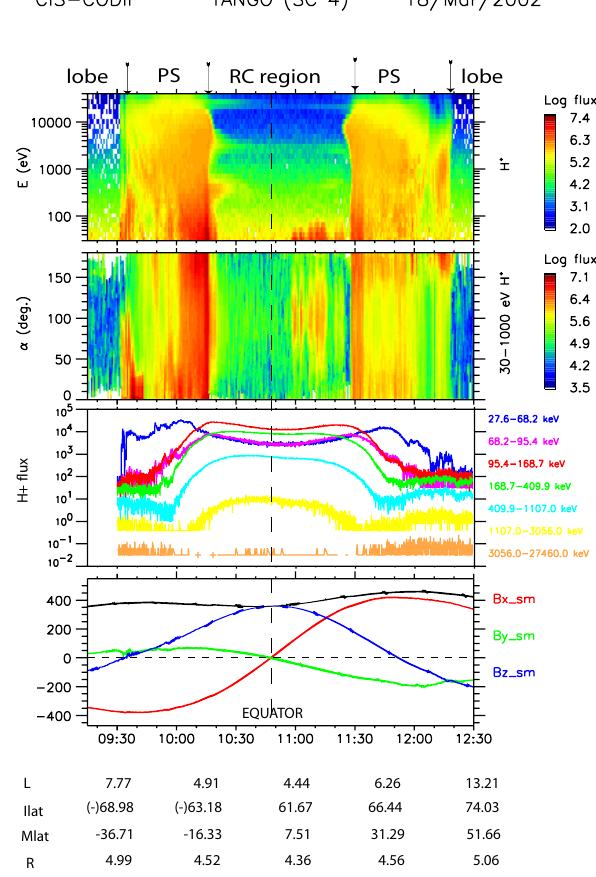
Fig. 7. Cluster SC4 data for the 18 March 2002 event: H + energy- time spectrograms in particle flux units (ions/cm 2 srskeV), the pitch-angle distribution (in particle flux units) for the 30 to 1000eV energy range, the H + energy-time spectrogram from the RAPID instrument (27.6–3056.0keV) and the magnetic field components in the SM coordinate system. L-shell, invariant latitudes, magnetic latitudes and geocentric distances are indicated below. The dashed line represents the equatorial